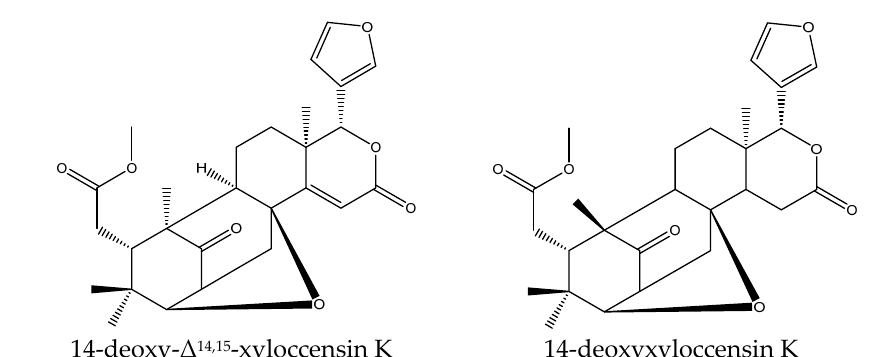
Figure 14. The structures of mexicanolides.